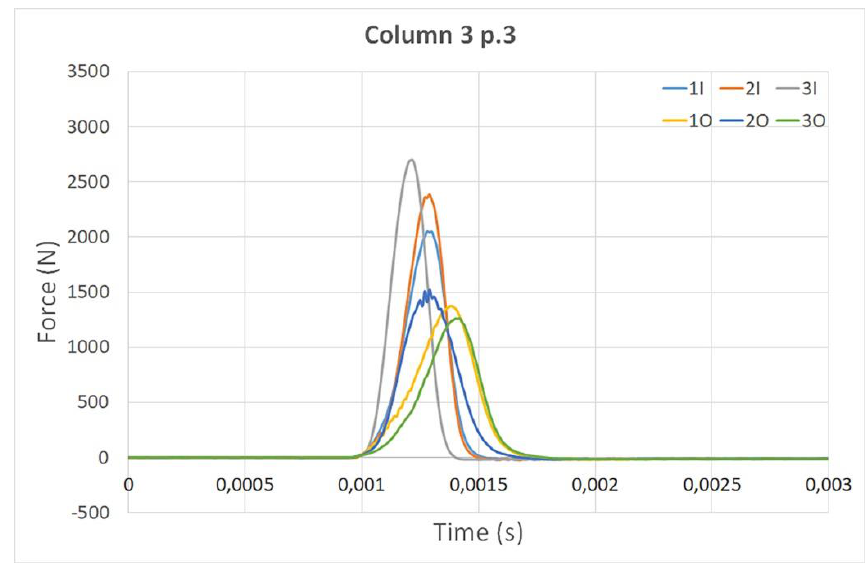
Figure 9. Time–force diagrams of third point of column 3 (I = point inside of the portico; O = outside of the portico).